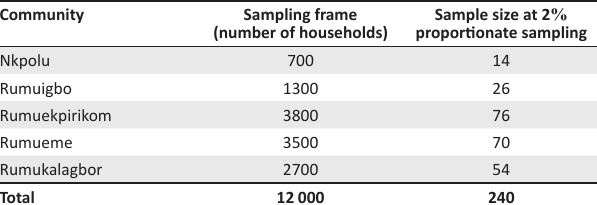
TABLE 1: Sample selection plan.